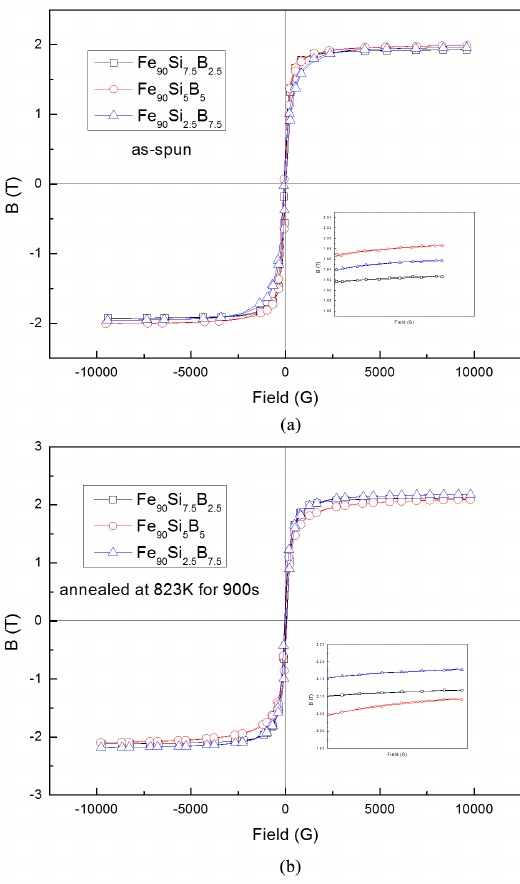
Figure 8. (a) High resolution XRD patterns (Cu-Kα, λ=1.5406) of Fe Si B ribbon at as-spun state and after annealing at 823K; (b) TEM 90 5 5 Bright-field image of Fe